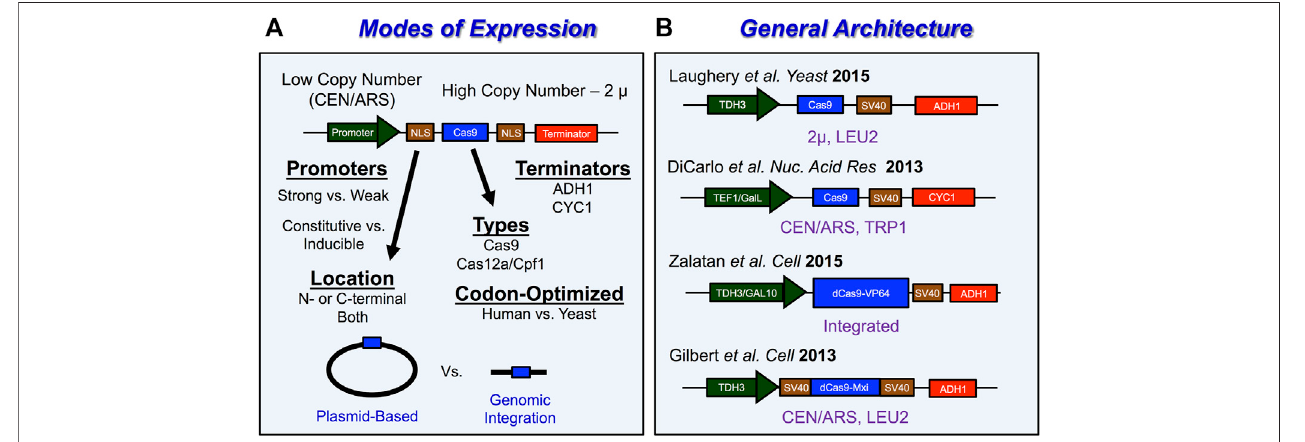
FIGURE5| TipsandtricksforexpressingCas9inS.cerevisiae (A) SchematicwithoverviewofimportantexperimentalconsiderationsforhowCas9isexpressedin yeast. Cas9 is typically expressed from vectors with low-copy number origins of replication like CEN/ARS or from high copy number origins of replication like 2 µ. PromotersforCas9expressiontypicallyinvolveeitherstrongorweakpromoters.Thechoiceofconstitutiveorinducibleexpressionandselectionofpromoterstrengthfor Cas9 are important considerations when looking to avoid potential Cas9-induced toxicity throughout the genome. A nuclear localization signal (NLS) is required to localize Cas9 in the nucleus of eukaryotic cells like S. cerevisiae . Importantly, Cas9 expression vectors have been used to introduce both Cas9 enzymes as well as Cas12a/Cpf1 enzymes in S. cerevisiae . Another consideration for optimizing Cas9 function in cells is codon optimization. Lastly, Cas9 expression vectors require terminators to stop transcription of Cas9. (B) Examples of Cas9 expression vector architecture. LEU2 and TRP1 are a commonly used selection markers for Cas9 expression vectors and can be useful to select for transformants as well as removal of Cas9 machinery from yeast cells. For more details see Stovicek et al., 2017; Raschmanová et al., 2018; Ding et al., 2020.